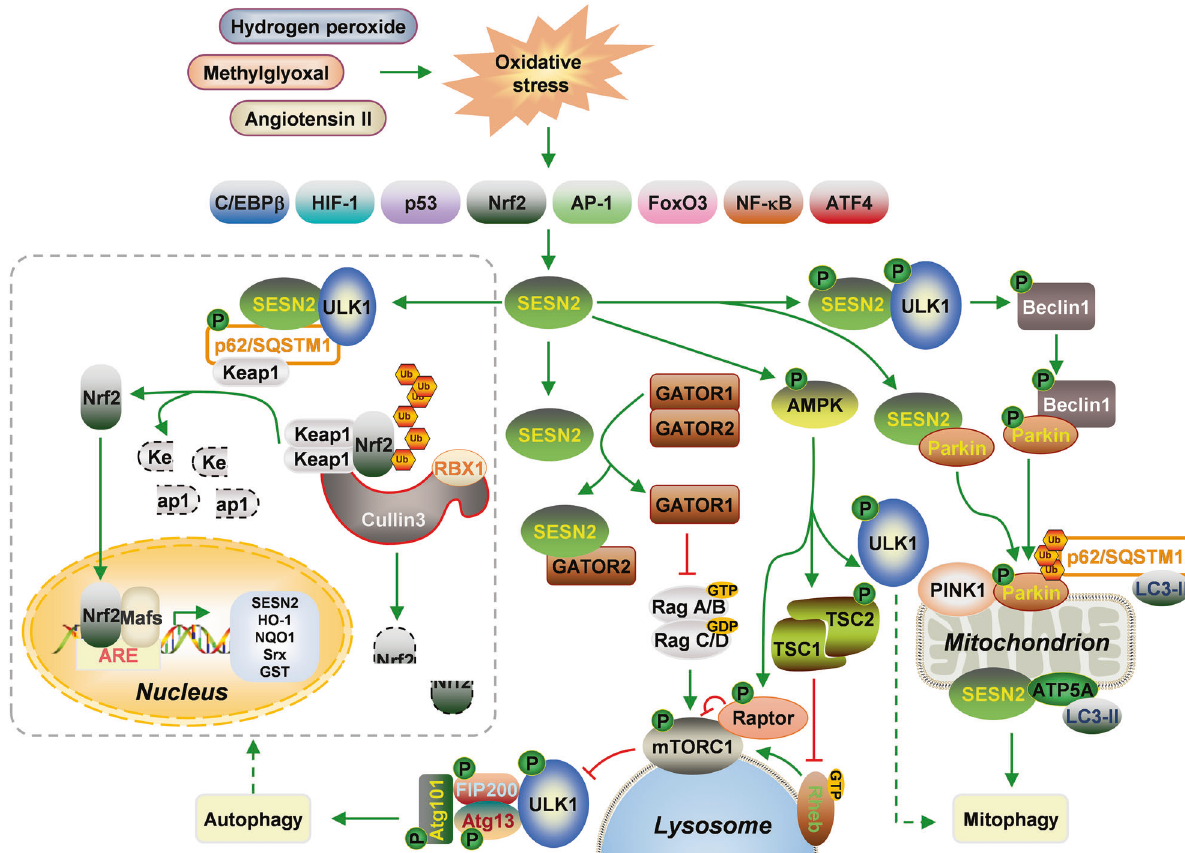
and ATF4. (i) SESN2 restrains mTORC1 activity through directly binding to GATOR2. GATOR1 is released from GATOR1/2 complex and inactivates Rag A/B via promoting GTP hydrolysis, which prevents mTORC1 binding and recruitment to lysosome. ULK1 is dissociated, then auto-phosphorylates, phosphorylates the complex components including Atg13, FIP200, and Atg101, and promotes autophagy. SESN2 also indirectly inactivates mTORC1 in an AMPK-dependent way. SESN2 promotes AMPK activation and Raptor phosphorylation to inhibit